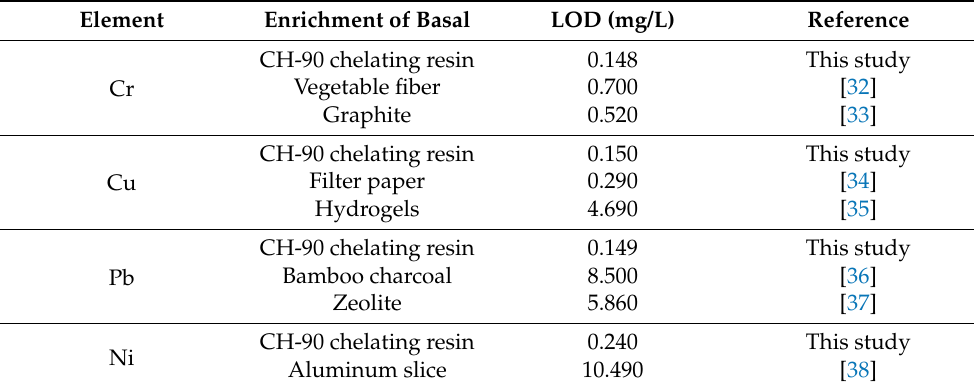
Table 1. Comparison of LODs of different enrichment substrates.